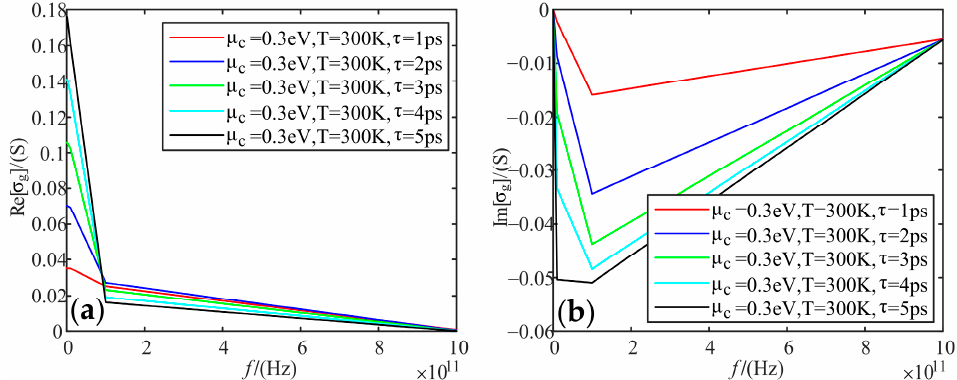
Figure 6. Variation of graphene total conductivity with frequency at different relaxation times: ( a ) real part; ( b ) imaginary part.